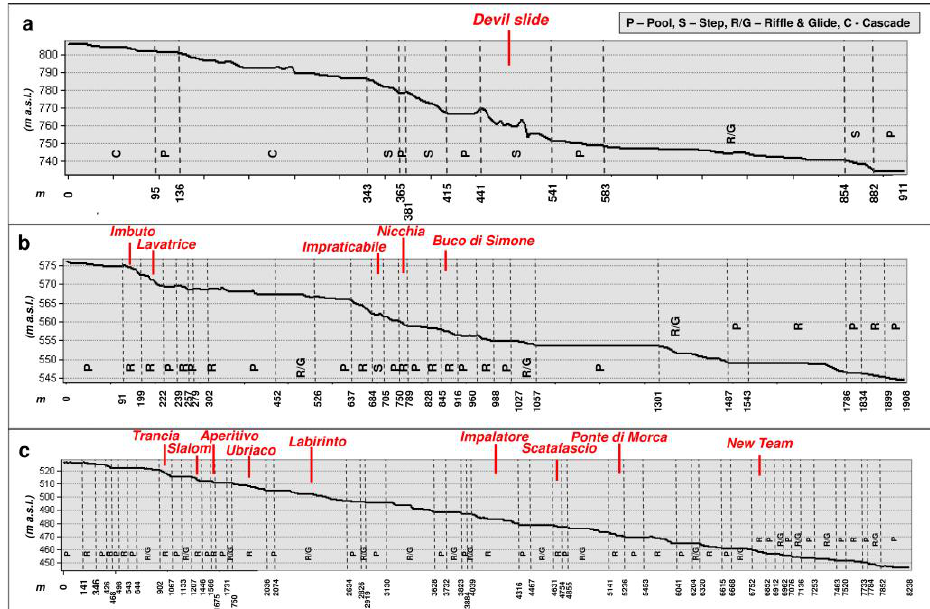
Figure 10. The longitudinal profile of the investigated segments of Canyoning Sorba (( a ) — CNS), Gole del Sesia (( b ) — GS), and Classico del Sesia (( c ) — CS). In red, the nicknames of specific traits of Gole del Sesia (( b )—GS), and Classico del Sesia (( c )—CS). In red, the nicknames of specific traits of the river, mainly rapids or steps, used in rafting and canyoning activities. the river, mainly rapids or steps, used in rafting and canyoning